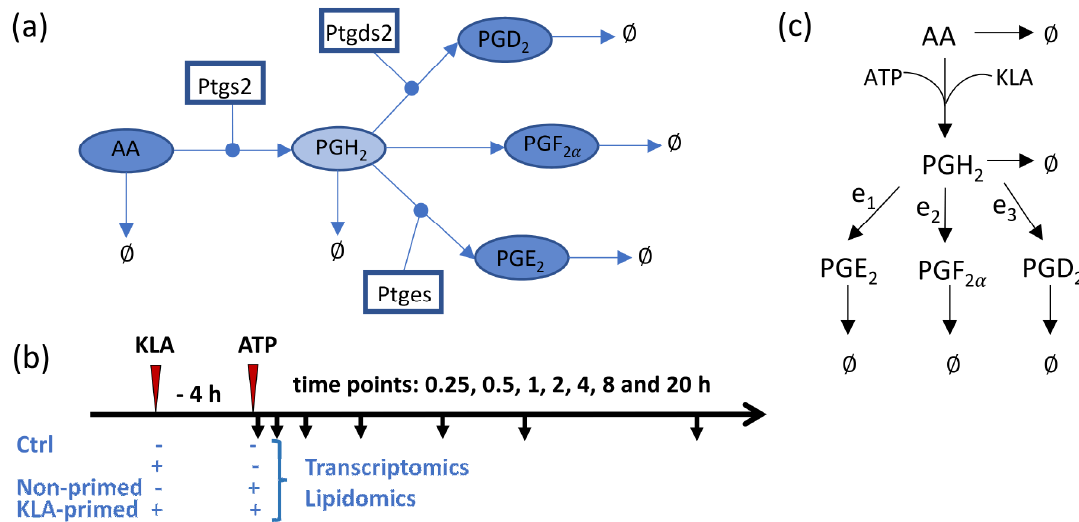
Figure 1. ( a ) The arachidonic acid metabolic pathway map for the breakdown of arachidonic acid into respective prostaglandin products via prostaglandin H2 (PGH 2 ) is shown: (rectangles) enzymes, (ellipses) lipid metabolites, (shaded) measured metabolites, (arrows) enzymatic and non-enzymatic reactions; ( b ) bone marrow derived macrophages (BMDM) were pretreated with or without KLA for 4 h and then stimulated with or without ATP. The media and cells were collected for lipidomic, tumor necrosis factor alpha (TNFα) and transcriptomic analysis at 0, 0.25, 0.5, 1, 2, 4, 8, and 20 h after